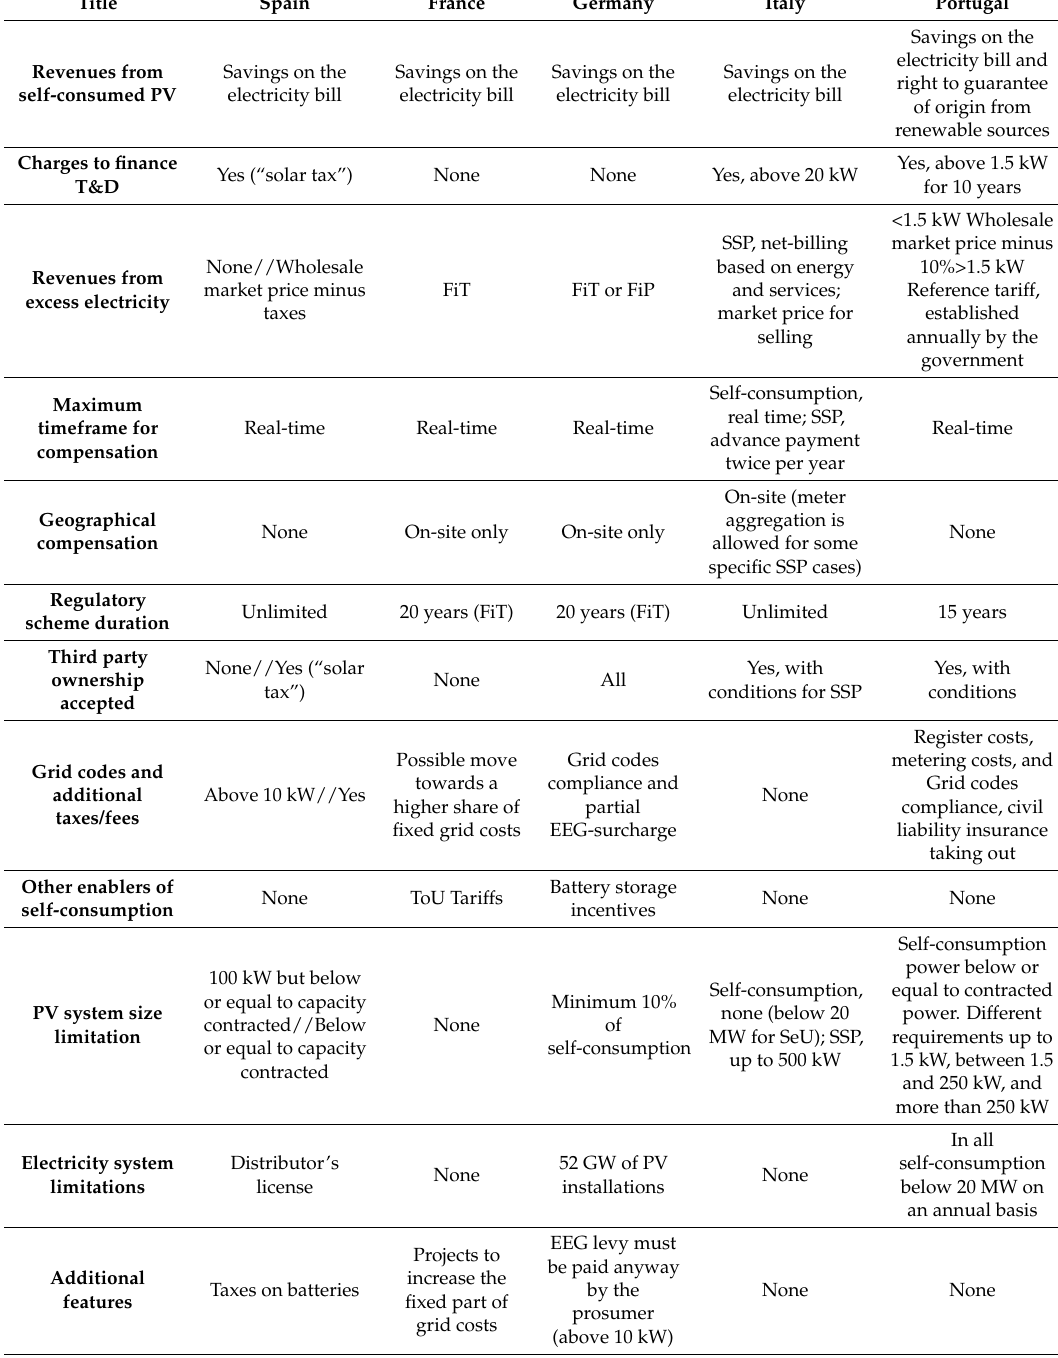
Table A1. Regulatory frameworks in the selected European countries (adapted from [61]) Acronyms: FiT: feed-in-tariff, FiP: feed-in-premium, SSP: Scambio Sul Posto (acronym in Italian, meaning Exchange on Site), ToU: time of use tariff, SeU: Sistema Efficiente di Utenza (acronym in Italian, meaning User Efficiency Systems), EEG: Erneuerbare-Energien-Gesetz (acronym in German, meaning Renewable Energy